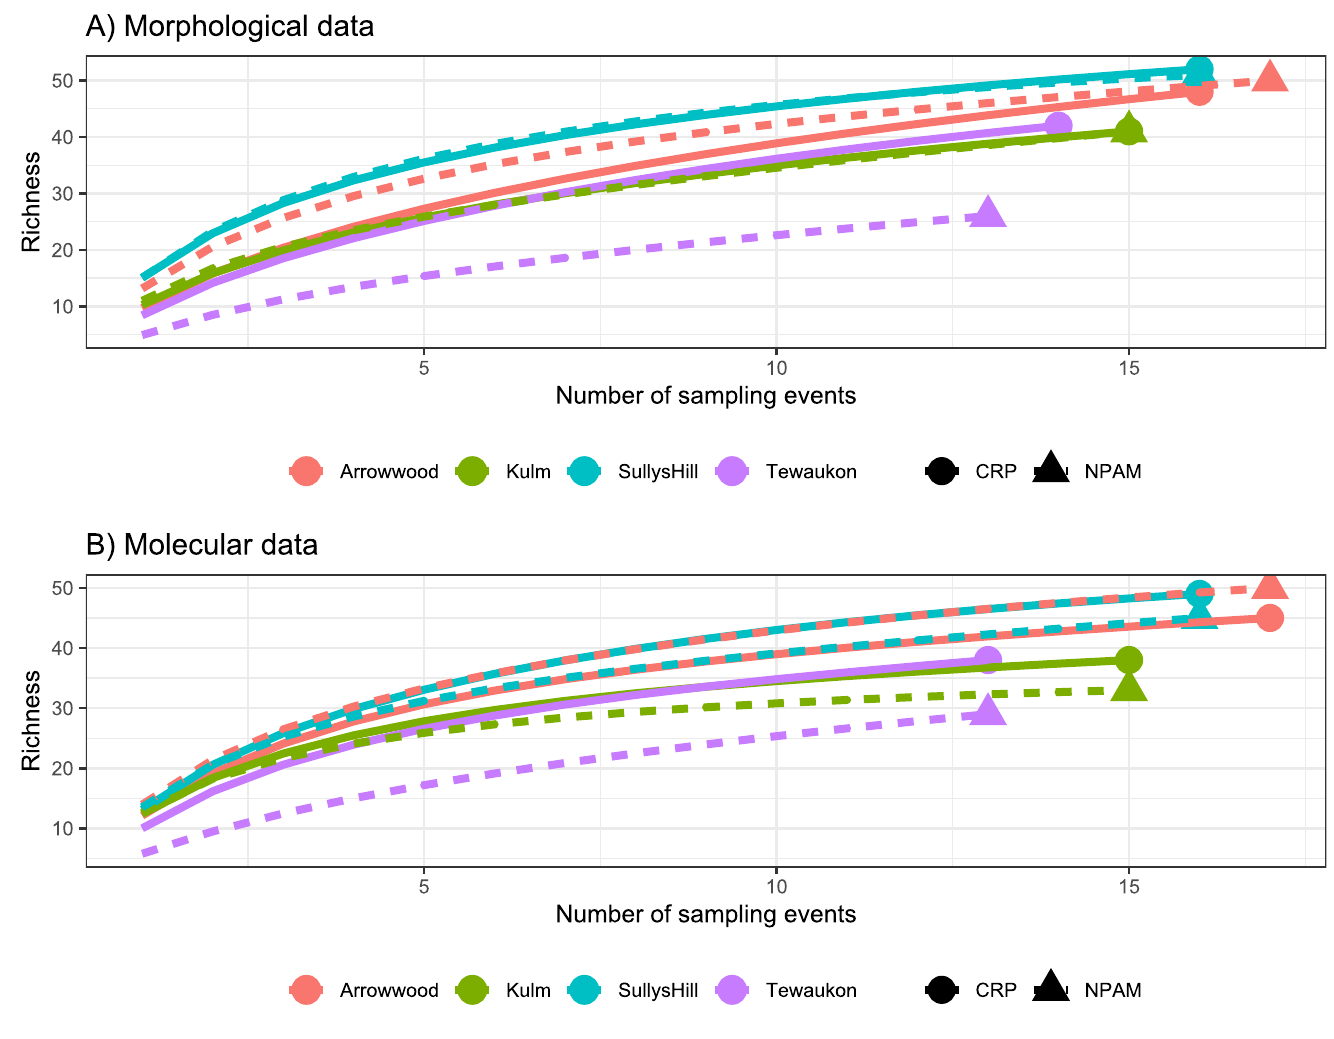
Fig 7. Species rarefaction curves. Rarefaction curves showing the expected number of species relative to the number of sampling units (horizontal axis), for the four locations (red = Arrowwood, green = Kulm, blue = Sully’s Hill, purple = Tewaukon) and two management regimes (dashed lines = CRP, solid lines = NPAM) based on A) morphological specimen identification, or B) molecular 28S LSU